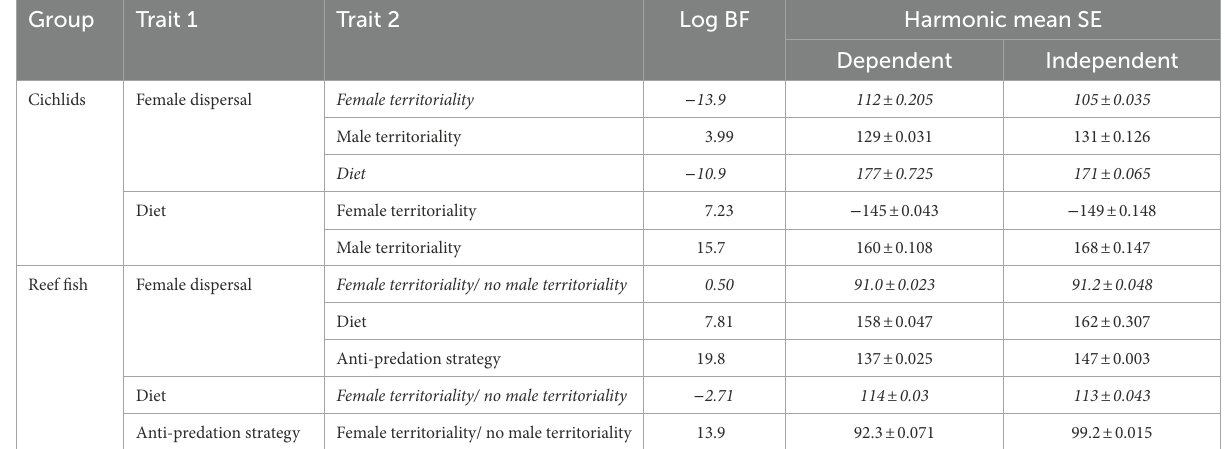
TABLE 2 Summary of the dependent and independent models of each of the given traits in each group.